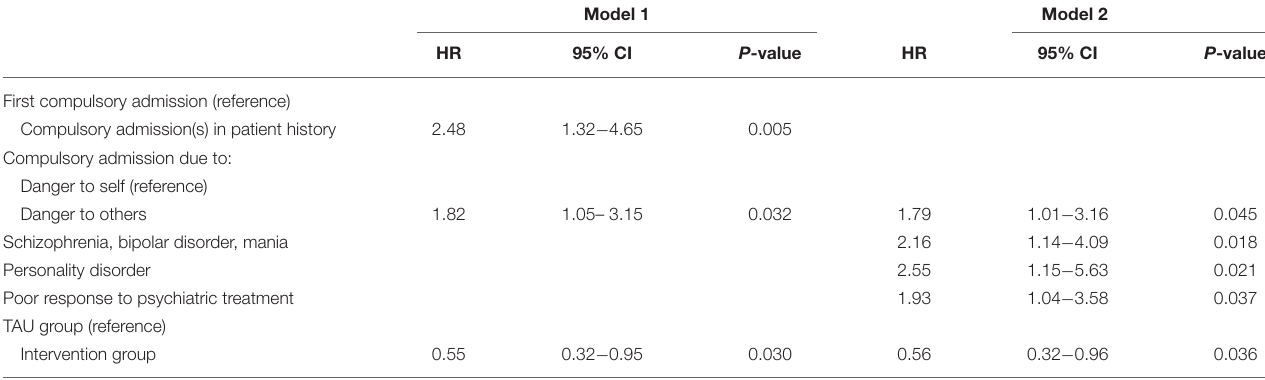
TABLE 3 | Risk factors for compulsory re-admission within 24 months (Cox